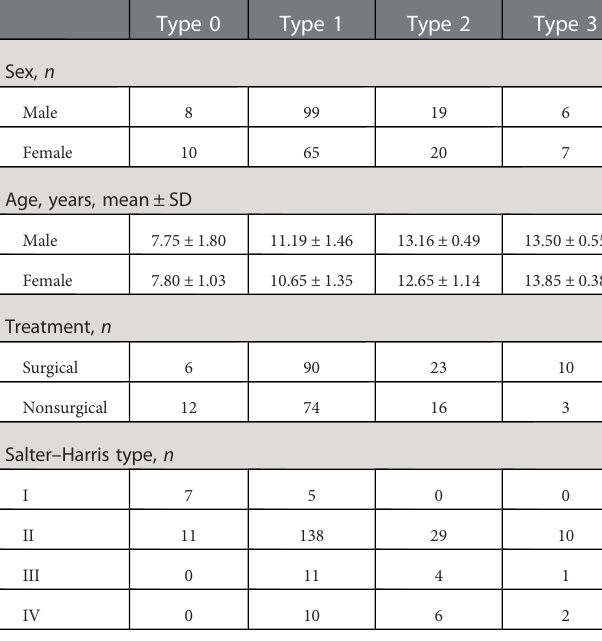
TABLE 2 Baseline characteristics of patients. TABLE 3 Occurrence rate of growth arrest lines in patients with different epiphyseal types.